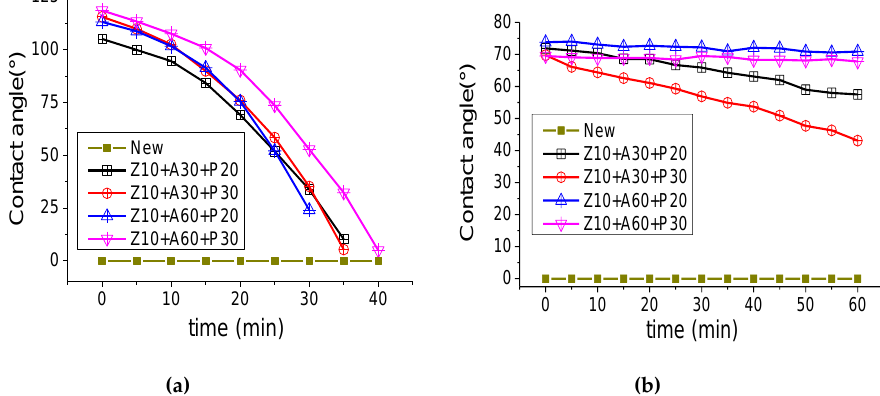
Figure 8. Dynamic change of contact angle of untreated insulating board and modified insulating board to water ( a ) and mineral oil ( b ).